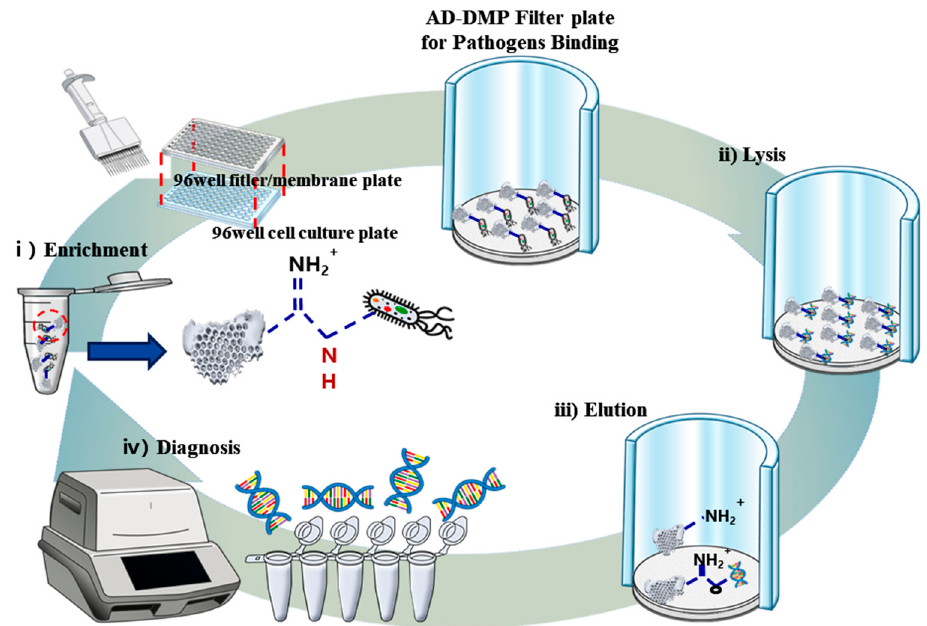
Figure 1. Schematic diagram of nucleic acids (NAs) enrichment and extraction via a filter/membrane plate system. Washed diatomaceous earth (DE) was modified with 3-aminopropyl-methyl-diethoxysilane (APDMS). With the help of the cross-linker dimethyl pimelimidate dihydrochloride (DMP), NAs of lysed pathogen samples can be interconnected with D-APDMS to form a solid covalent bond. The formed complex could collect NAs by using elution buffer (pH > 10).